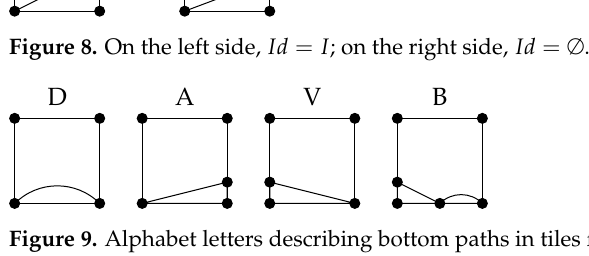
Figure 7. Additional letter H is used to describe one special picture. In this case, P t = H , Id = ∅ , P = ∅ . b